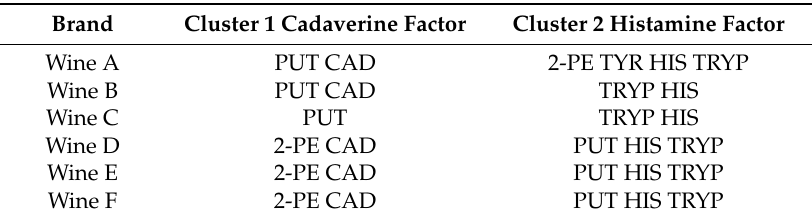
Table 2. Cluster composition for variables for 6 wine brands.